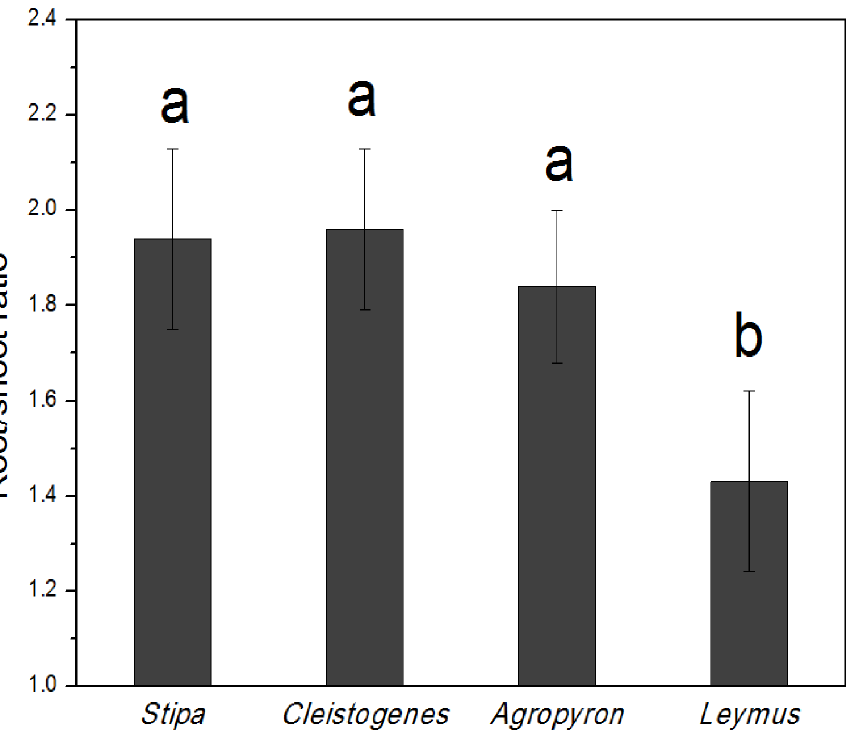
Figure 2. Root/shoot ratios (mean ± 1 SE) of four grasses genera ( Stipa , Cleistogenes , Agropyron , and Leymus ). Bars with dissimilar letters denote signiffcant difference ( p , 0.01).